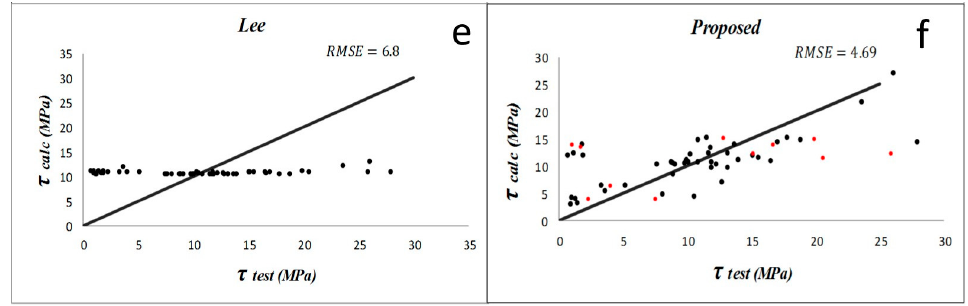
Figure 7. Bond strength prediction results by different models ( a – f ) on the concrete with high strength and non-sand-coated FRP bars (study group 3). The data used for validation are shown as red points in figure ( f ).